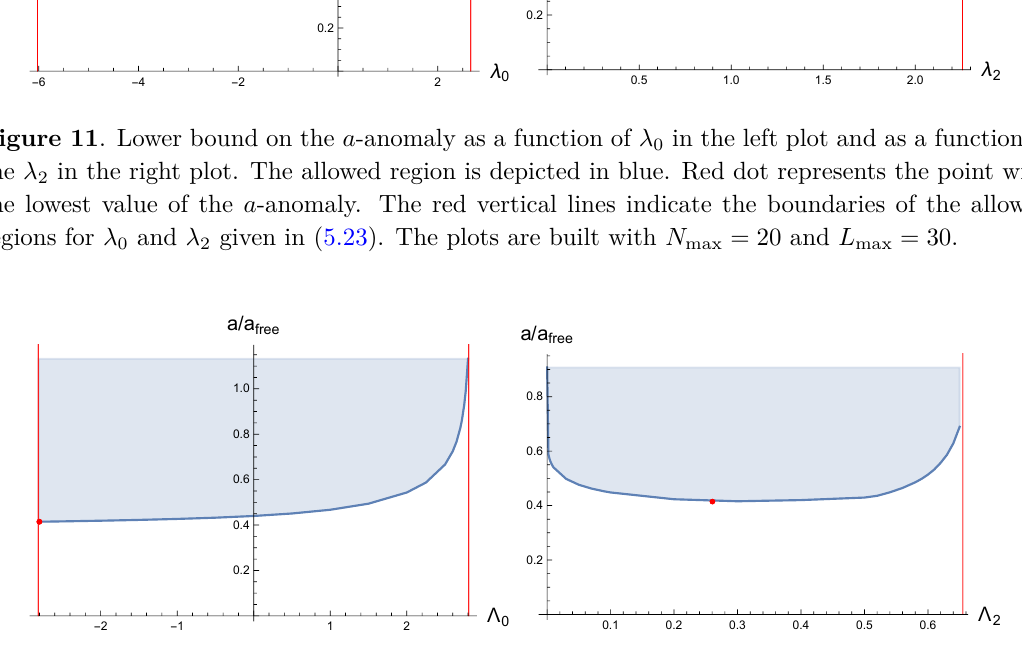
Figure 12 . Lower bound on the a -anomaly as a function of Λ 0 in the left plot and as a function of the Λ 2 in the right plot. The allowed region is depicted in blue. Red dot represents the point with the lowest value of the a -anomaly. The red vertical lines indicate the boundaries of the allowed regions for Λ 0 and Λ 2 given in (5.23). The plots are built with N max = 20 and L max = 30